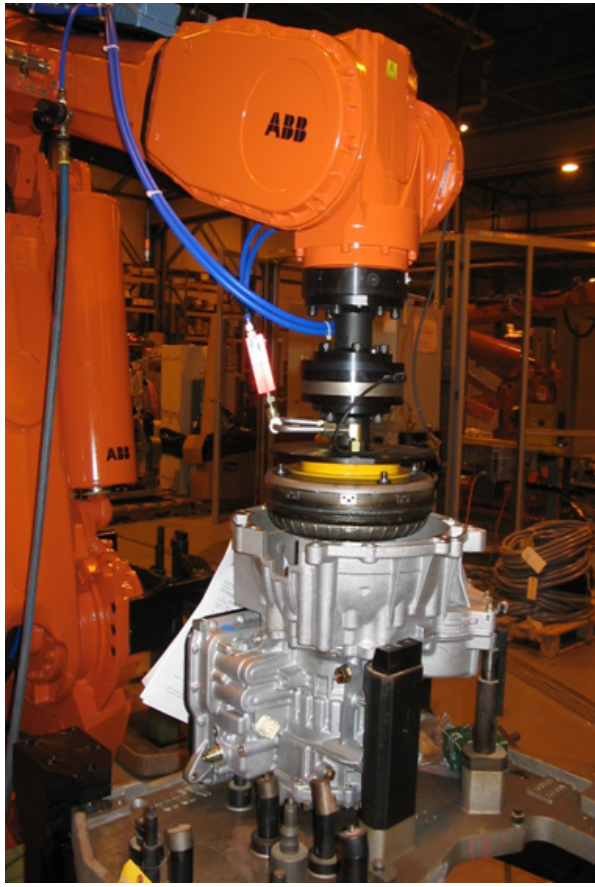
Figure 10: Example of installation using force con- trolled assembly of a torque converter.